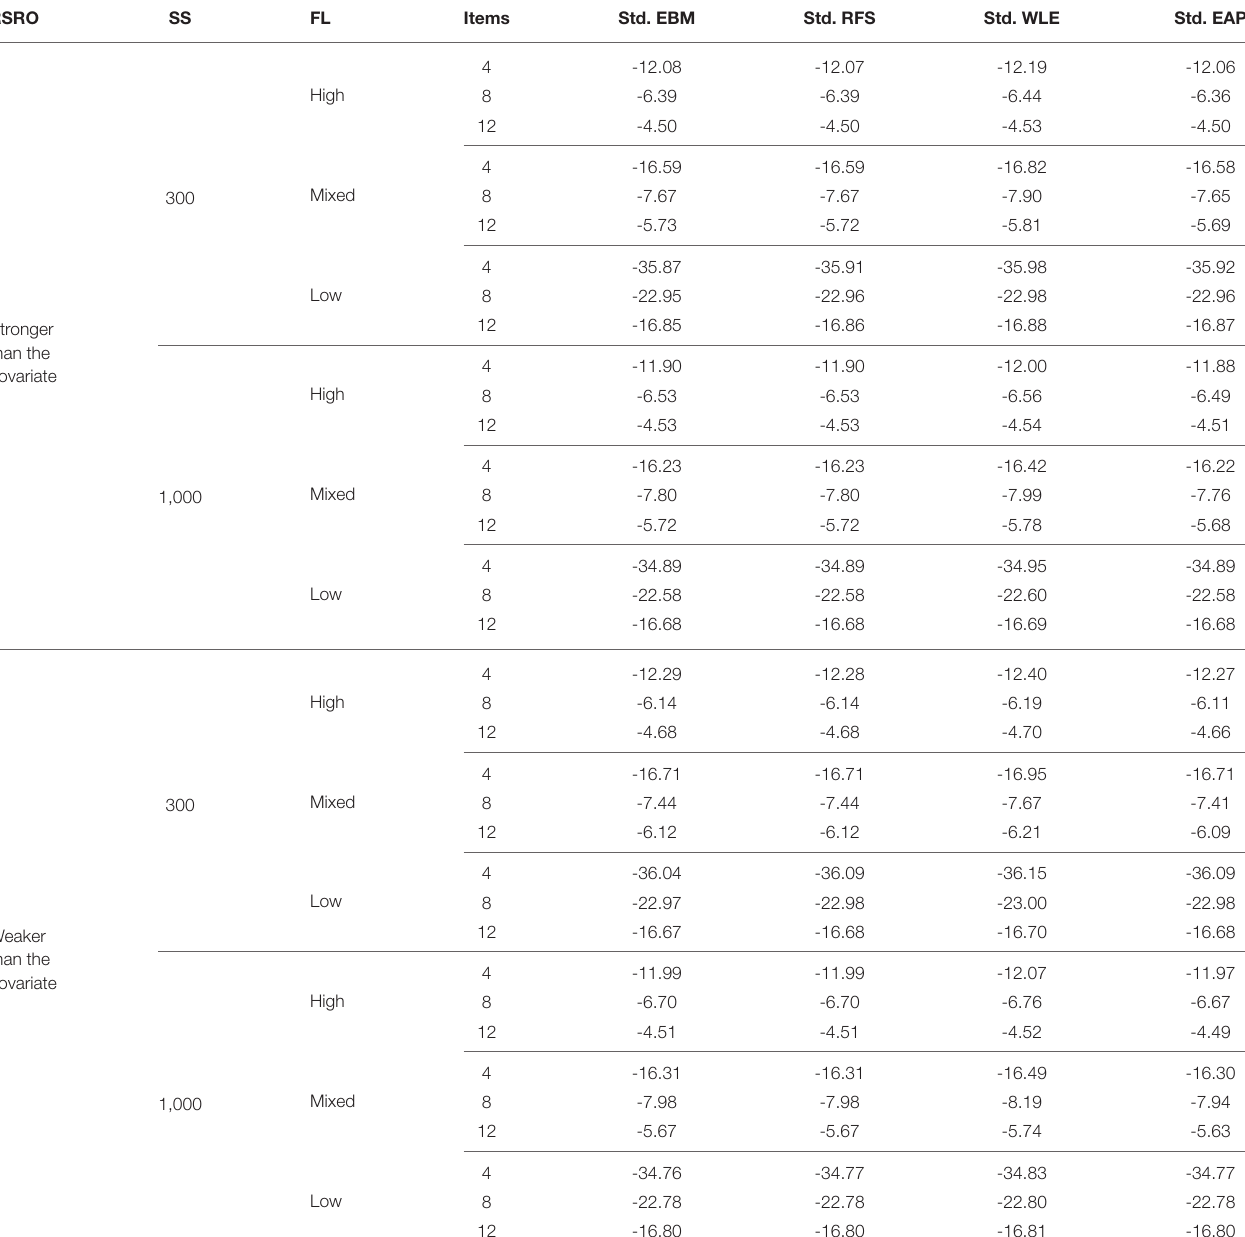
TABLE A1 | Mean percentage bias of regression coefficient of the skill for standardized test scores apart from SMS.